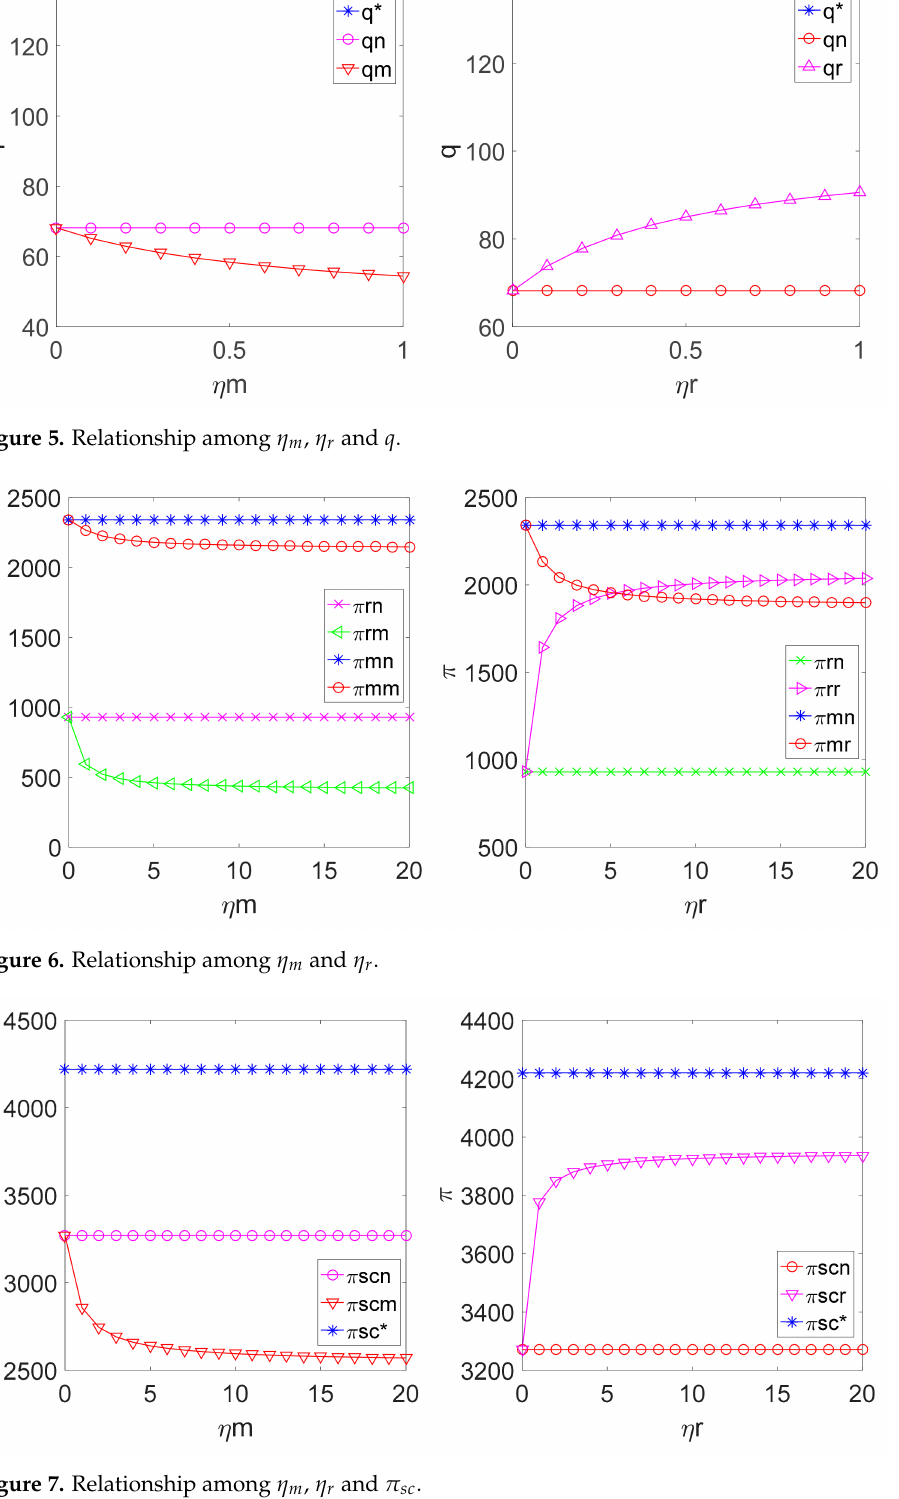
Figure 7. Relationship among η m , η r and π sc